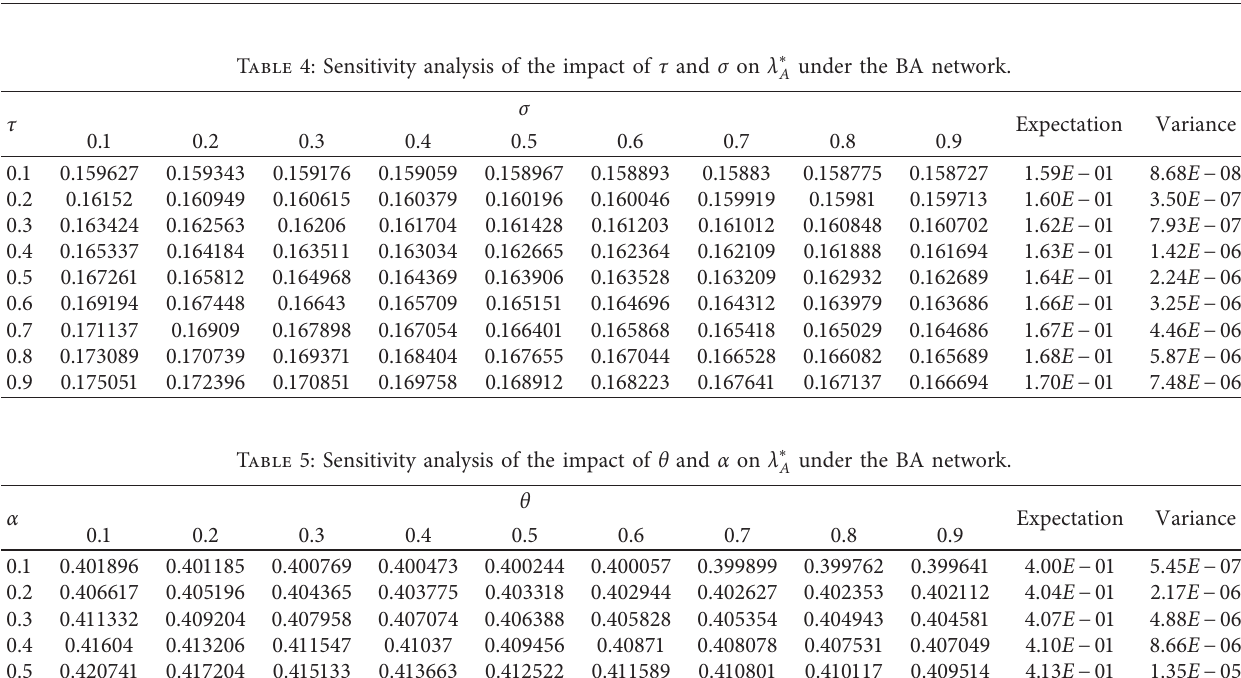
Table 4: Sensitivity analysis of the impact of τ and σ on λ ∗